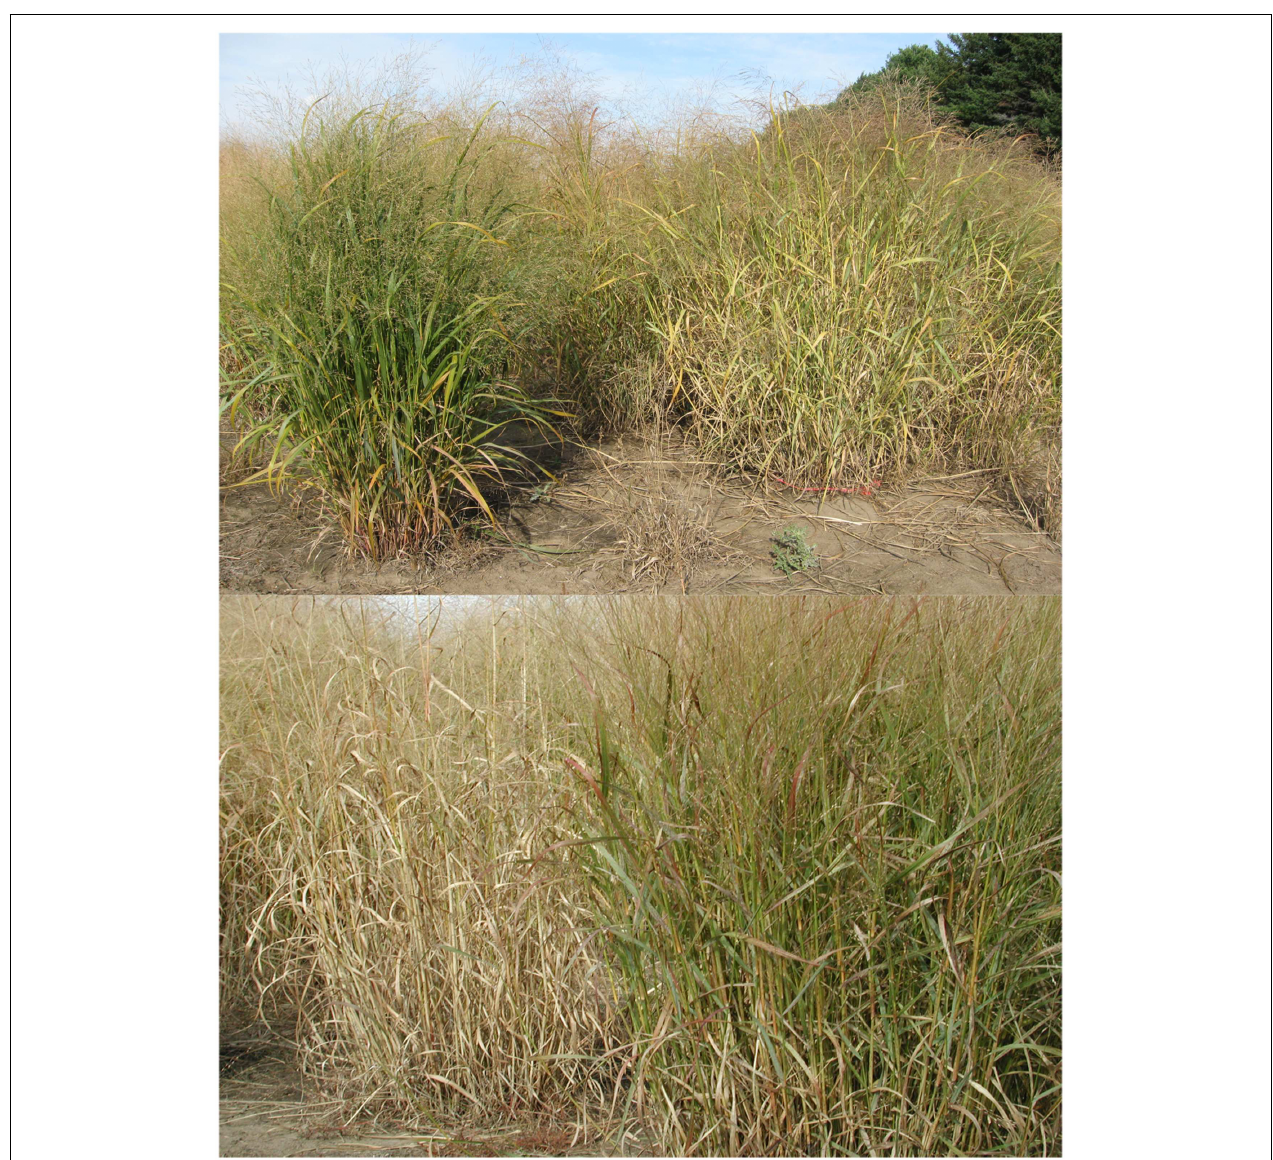
FIGURE 1 | Switchgrass varieties in a common garden with differences in senescence.